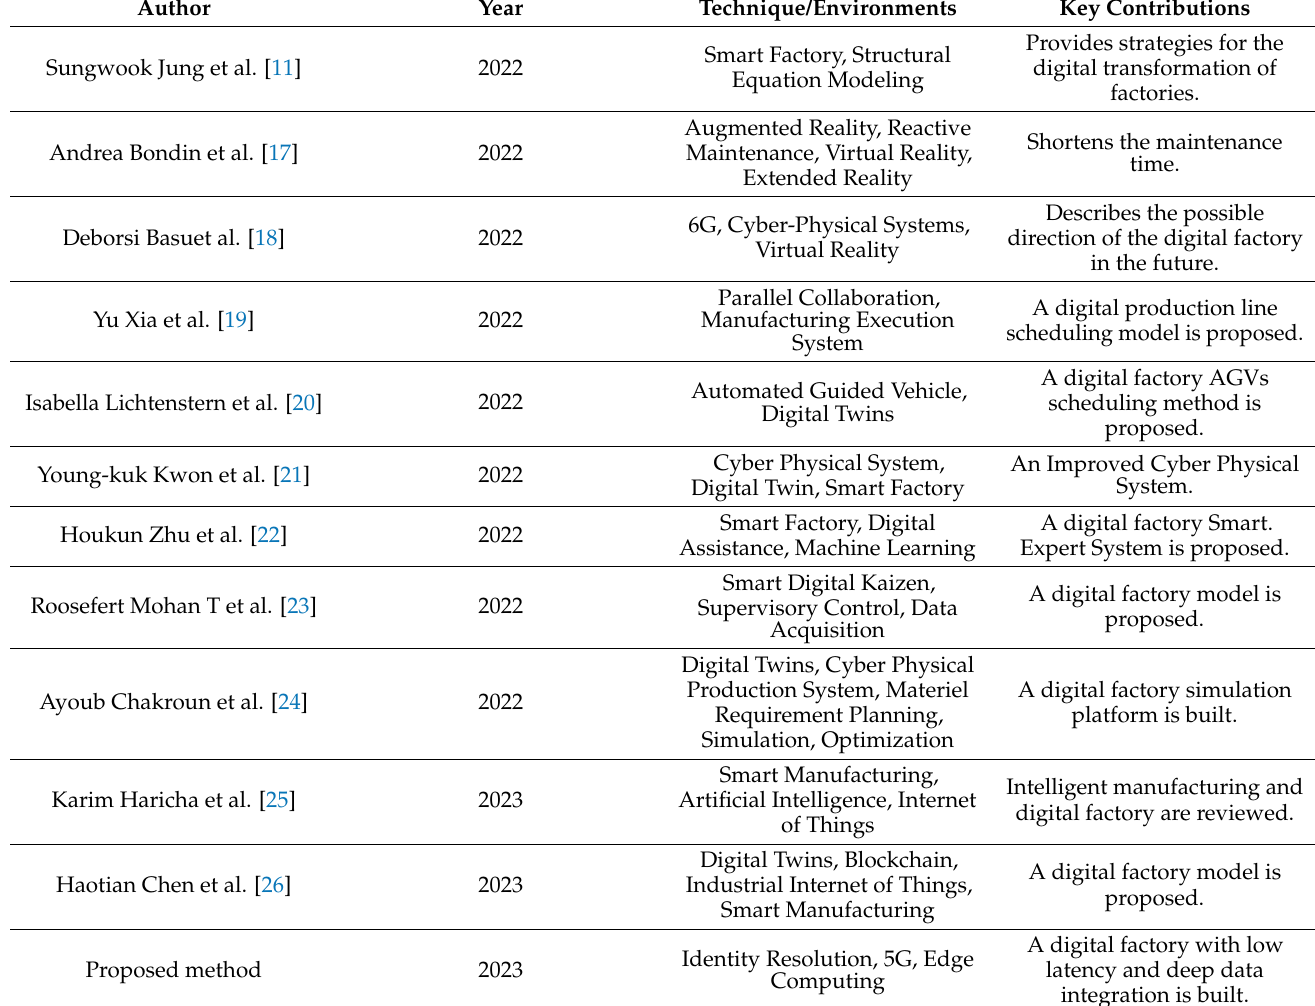
Table 1. Summary of existing